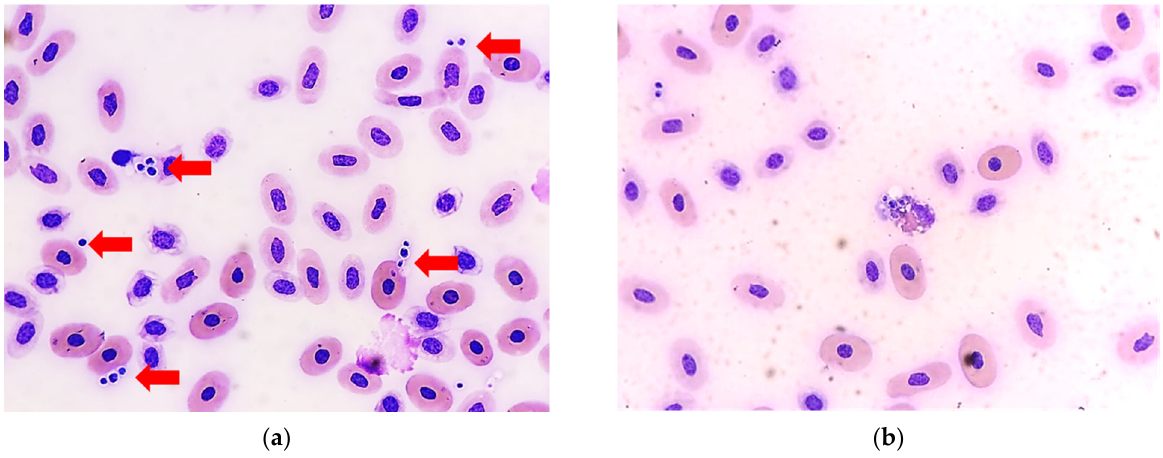
Figure 2. ( a ) Groups of round- to oval-shaped yeast cells were observed in the blood smear of the sea turtle (red arrow). ( b ) Some yeast cells were ingested by a heterophil (Wright-Giemsa stain, 400× original magnification).